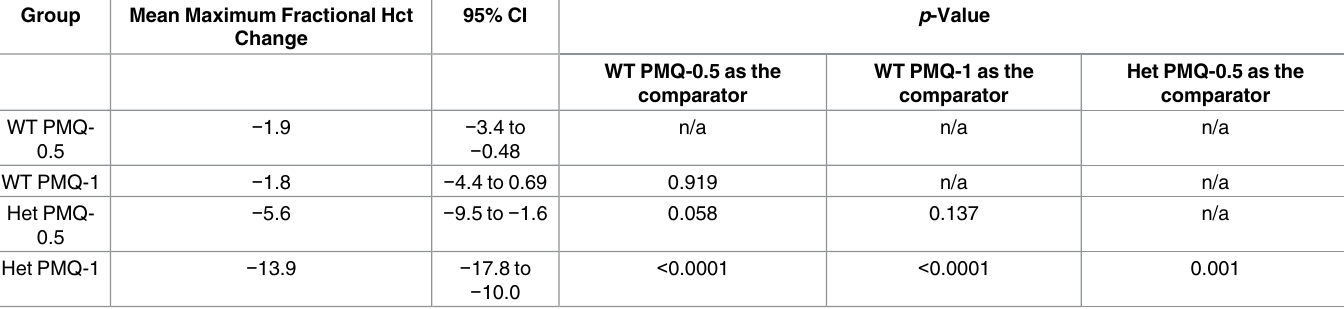
Table 3. Comparison of the mean maximum individual fractional haematocrit reductions between G6PD heterozygous and wild-type females tak- ing PMQ-1 or PMQ-0.5 adjusted for initial parasitaemia. Group Mean Maximum Fractional Hct Change